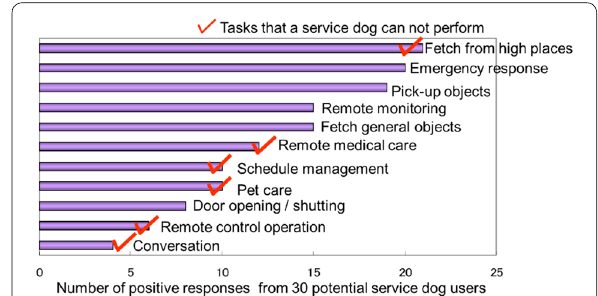
Fig. 5 Results of questionnaire investigated with JSDA